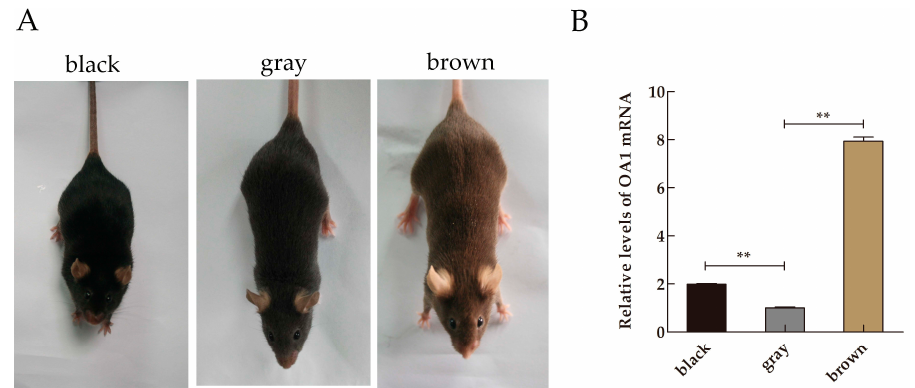
Figure 1. The ocular albinism type 1 ( OA1 ) mRNA analysis. ( A ) Photographs of C57BL/6J mice with a variety of coat colors; ( B ) Relative expression levels of OA1 mRNA in the mice skin samples of different coat colors. The abundance of OA1 was normalized relative to the abundance of β -actin . Data are shown as the mean ± standard errors ( n = 3 each), ** p < 0.01.